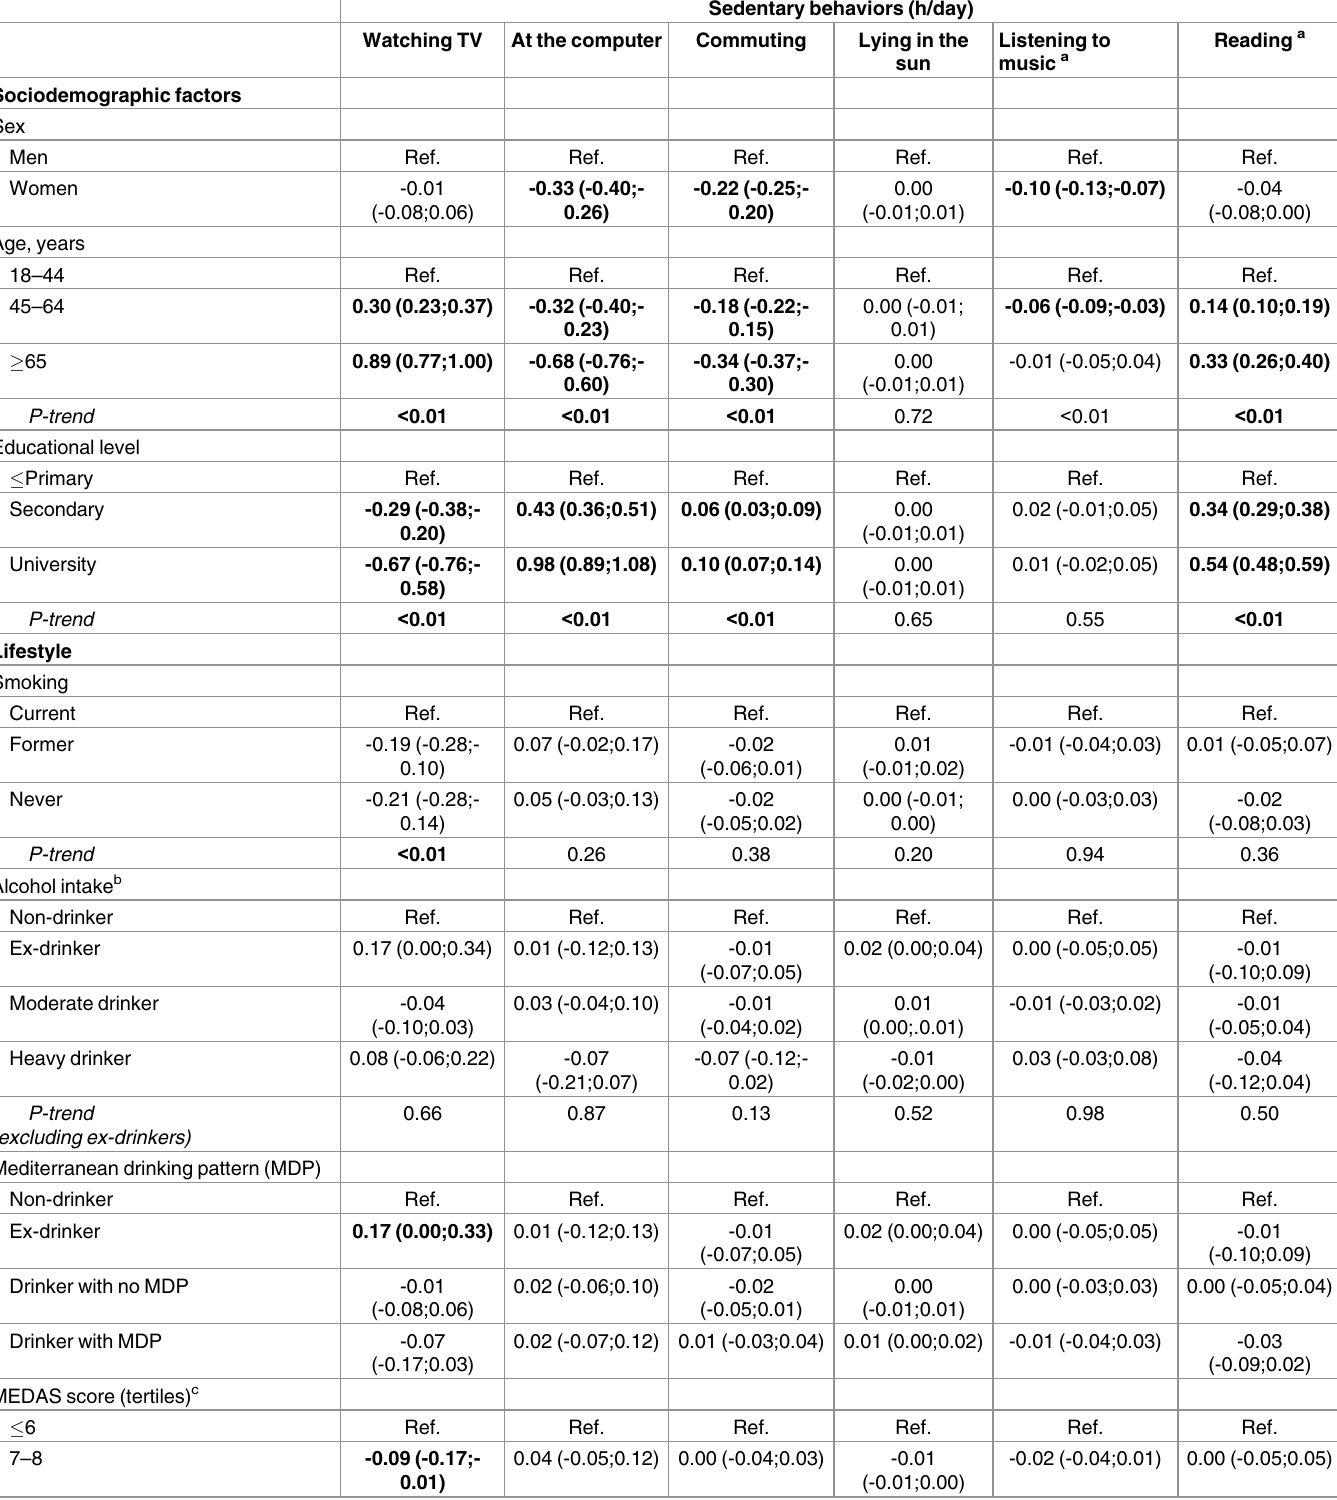
Table 3. Beta regression coefficients (95% confidence interval) for the association of sociodemographic factors, lifestyle and morbidity with time spent in sedentarybehaviors in the adult population of Spain (ENRICA study, N =